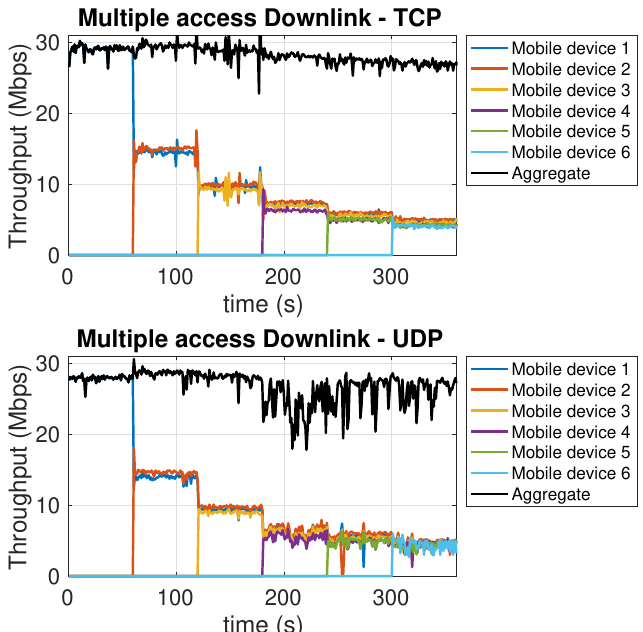
Figure 7. Multiple access downlink with TCP (top chart) and UDP (bottom chart).